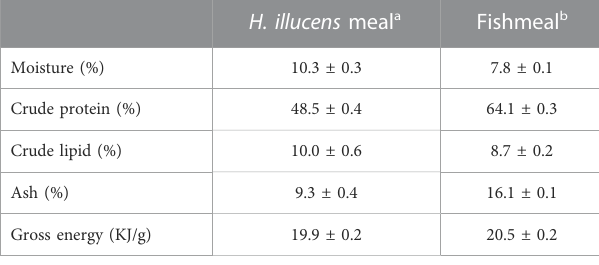
TABLE 1 Proximate composition (% of wet weight) of the partially defatted H. illucens meal and of fi shmeal used in the experimental diets. H. illucens meal